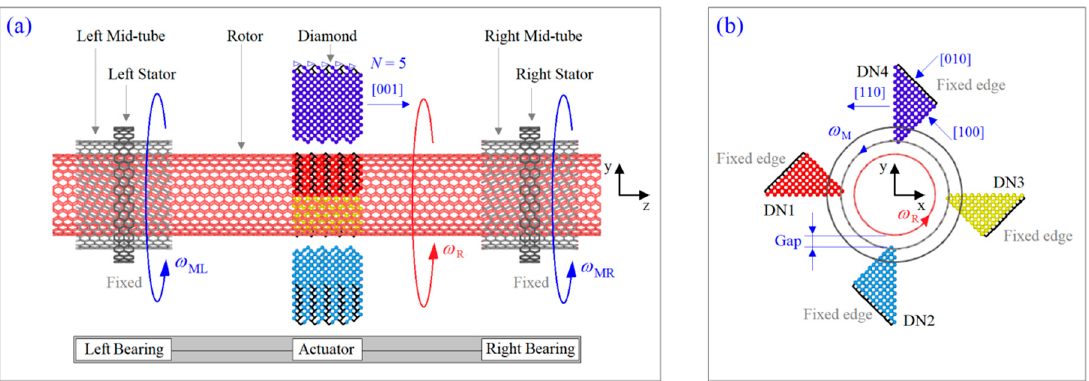
Figure 1. Schematic model of a diamond-excited nanomotor from tri-walled carbon nanotubes. ( a ) Side-view of system, ( b ) axial-view of system.